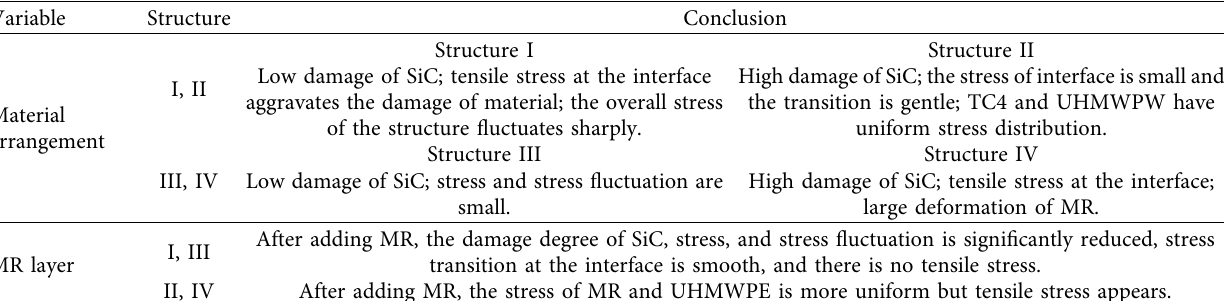
Table 5: Comparison of dynamic mechanical